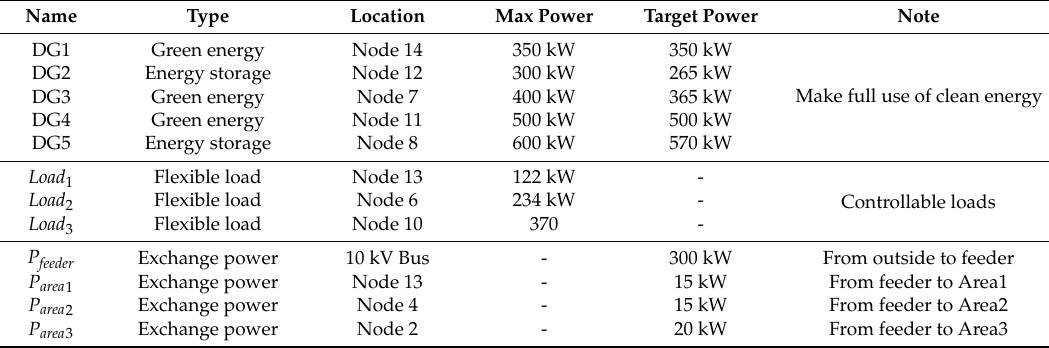
Table 3. Main electrical specifications of feeder system and operation target.